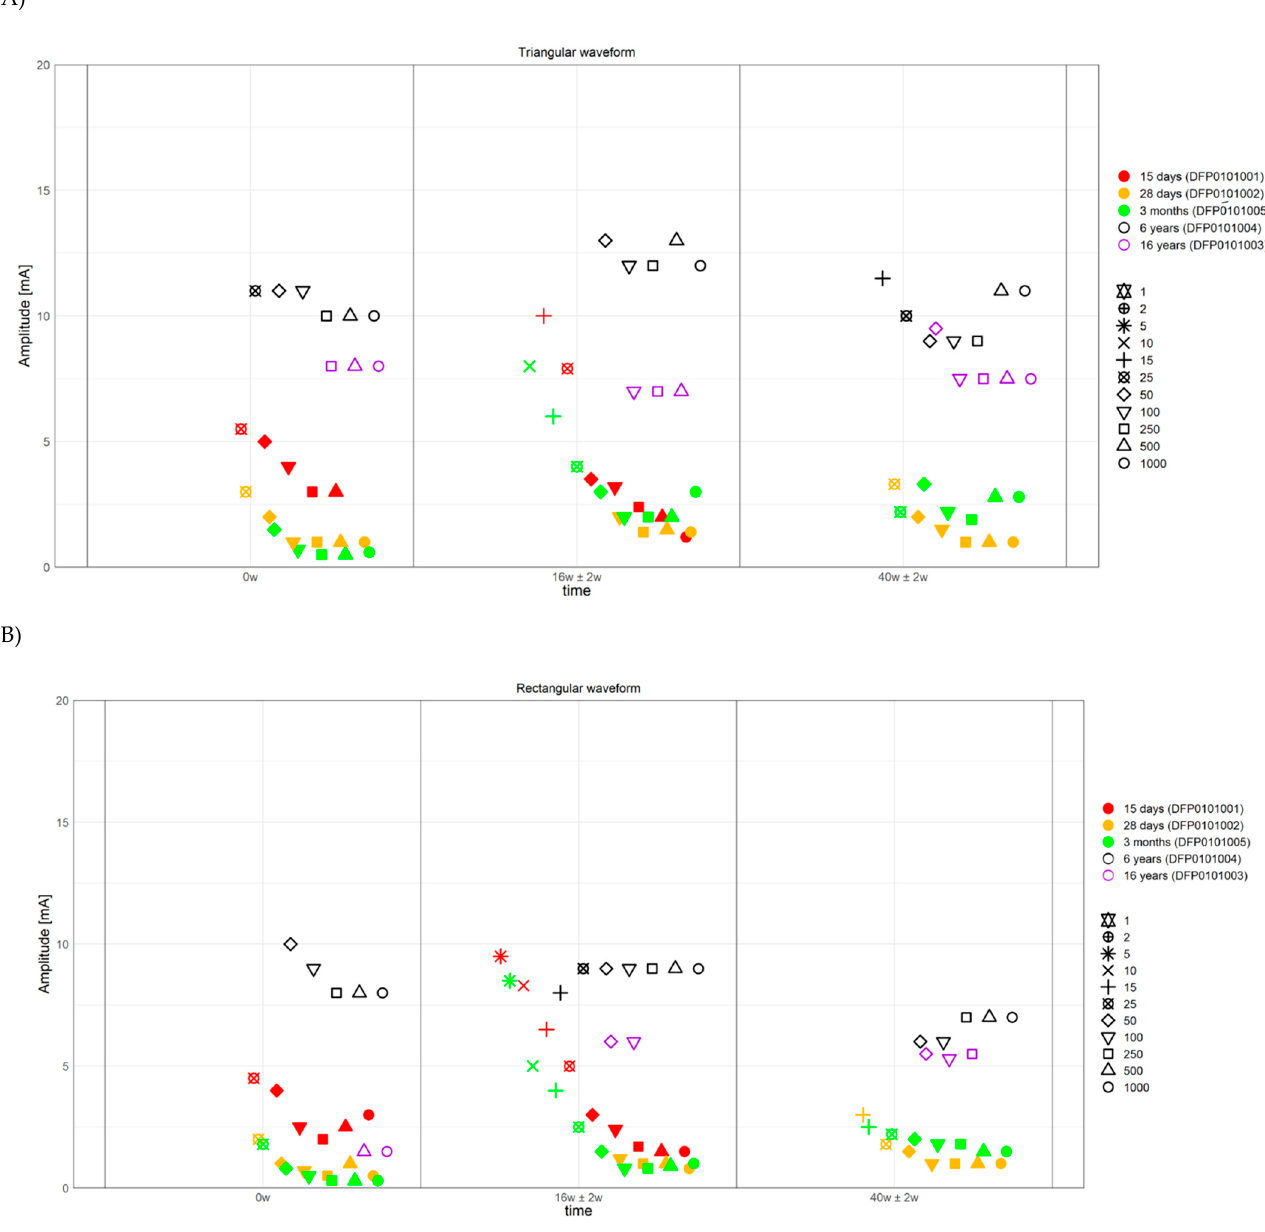
Figure 4. Strength duration curves of all the assessed patients. ( A ) Amplitude required to observe a selective ZYG response ( y -axis) with triangular waveform stimulation, at selected visits ( x -axis). ( B ) Amplitude required to observe a selective ZYG response ( y -axis) with rectangular waveform stimulation, at selected visits ( x -axis). The colors describe the facial paralysis duration and the form of the plotted outcome the applied PW. ms = milliseconds, mA = milliampere, w = week.